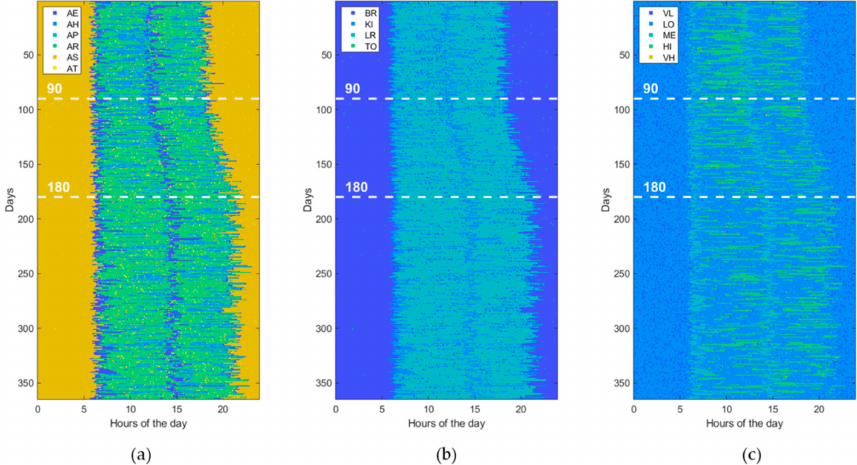
Figure 7. Example of an abnormal data set, due to a change in “Duration of activity” (Du). The change gradually takes place from the 90th day on. ( a ) ADL, ( b ) LOCs, and ( c )